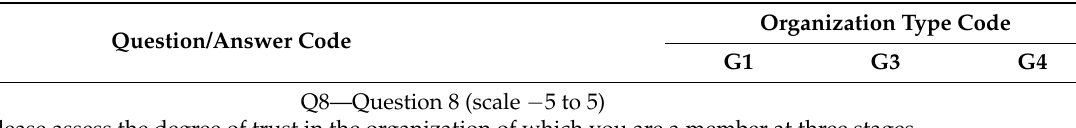
Table 2. Mean values of ratings by three types of organizations (G1, G3, and